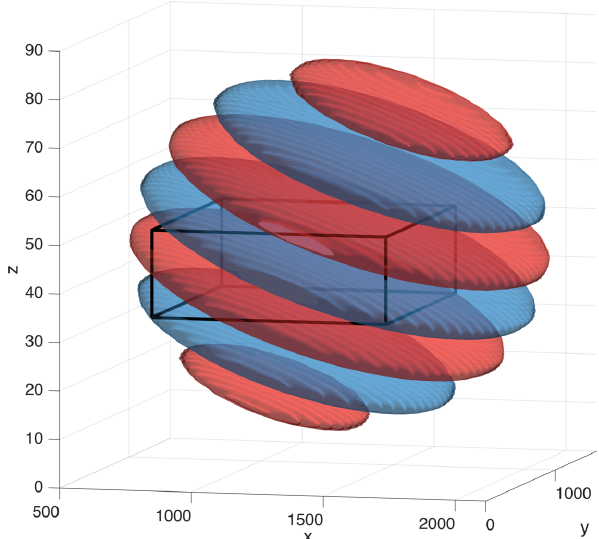
Figure 3. Example figure illustrating the method used for our ar- tificial wave tests. Each wave is a 3D sinusoid with a specified amplitude, three-dimensional wavelength (λ x ,λ y ,λ z ) and rotation (θ x ,θ y ,θ z ) relative to the axes of a 3D Cartesian grid of the same volume as a typical AIRS granule. Red and blue surfaces show 3D contours of a fixed positive (red) and negative (blue) magnitude; values are arbitrary but show the same absolute values for red and blue. Each output parameter is averaged across the region at the centre of the volume indicated by the black box, with dimensions of 800km × 800km ×